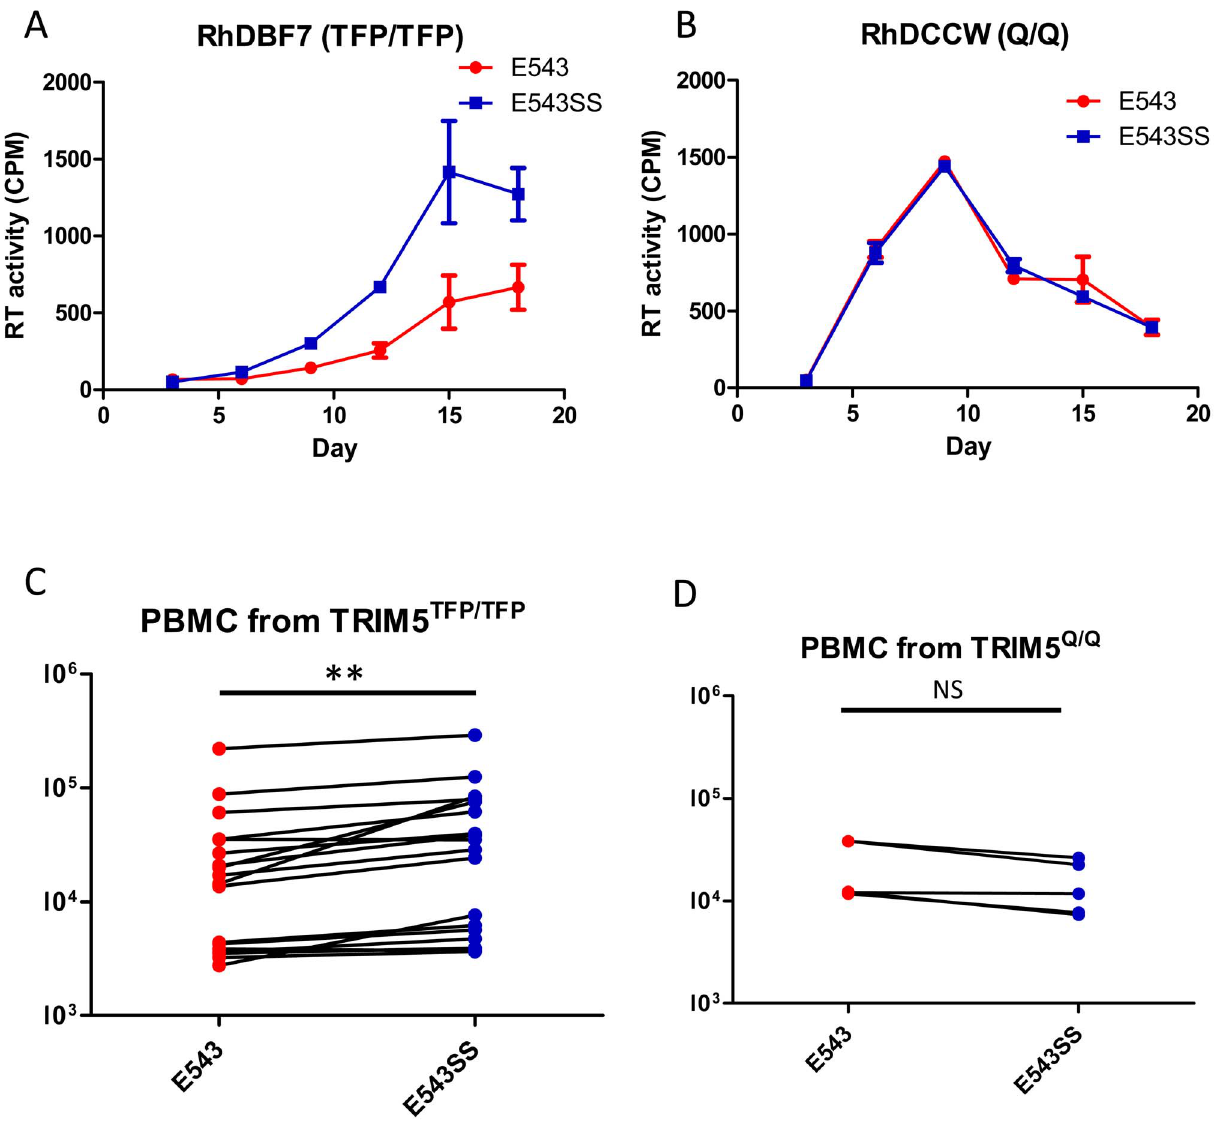
Figure 5. Comparison of PBMC infection with SIVsmE543-3 and SIVsmE543-3 S 37 S 98 . PBMCs were collected from 18 macaques with a TRIM5 TFP/TFP genotype and 5 macaques with a TRIM5 Q/Q genotype and activated with PHA for 3 days. Activated PBMCs were infected with SIVsmE543-3 and SIVsmE543-3 S 37 S 98 at a M.O.I. of 0.001. Virus production was quantified and shown as RT values in supernatants collected at 3-day intervals. A and B show the replication kinetics of SIVsmE543-3 and SIVsmE543-3 S 37 S 98 in PBMCs of representative macaques RhDBF7 (TRIM5 TFP/TFP ) and RhDCCW (TRIM5 Q/Q ). Area under the replication curve (AUC) of SIVsmE543-3 and the variant were calculated for each macaque separately. The AUC of SIVsmE543-3 and its variant in the TRIM5 TFP/TFP group (C) and the TRIM5 Q/Q group (D) are shown and compared by paired t